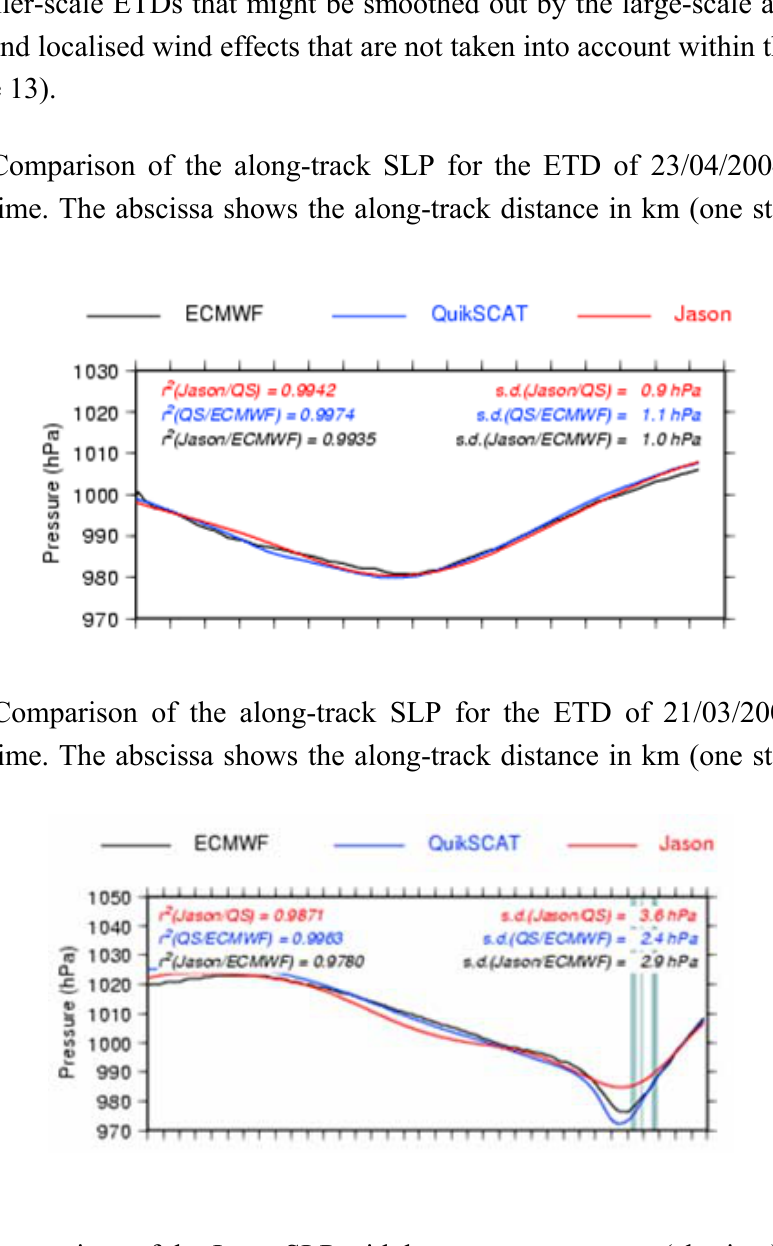
Figure 14. Comparison of the Jason SLP with buoys measurements (abscissa). The colored bar gives the SLA in